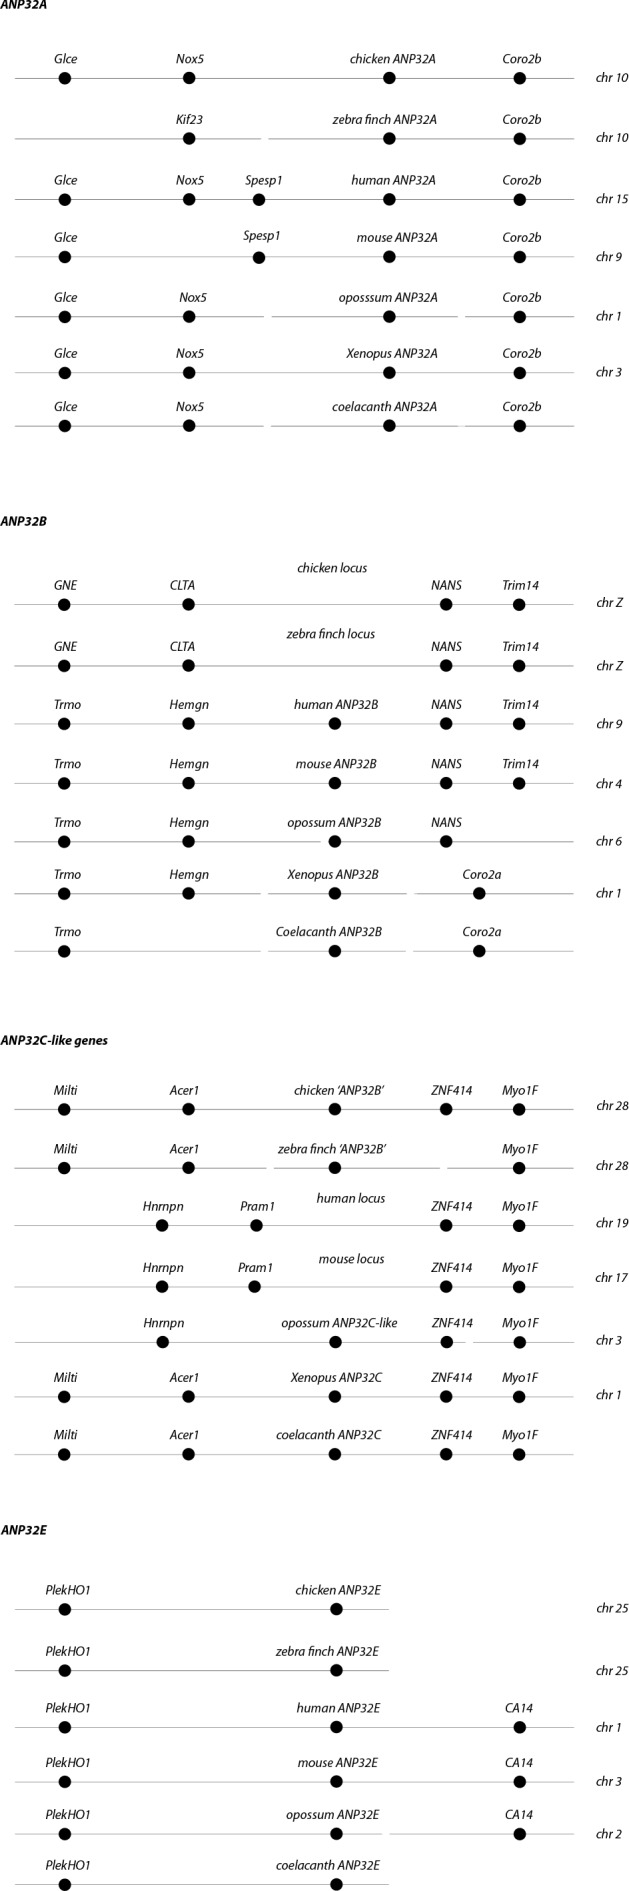
Synteny of ANP32 genes.Chromosome locations of ANP32 family members A, B, C and E from coelacanth (Latimeria chalumnae), Xenopus (Xenopus tropicalis), chicken (Gallus gallus), zebra finch (Taeniopygia guttata), opossum (Monodelphis domestica), mouse (Mus musculus) and Human (Homo sapiens).